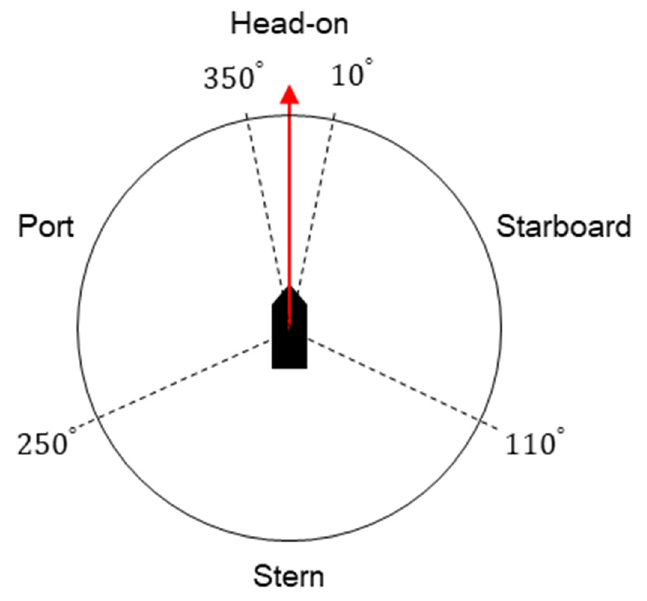
Figure 3. Diagram showing position of other ship relative to our own ship.